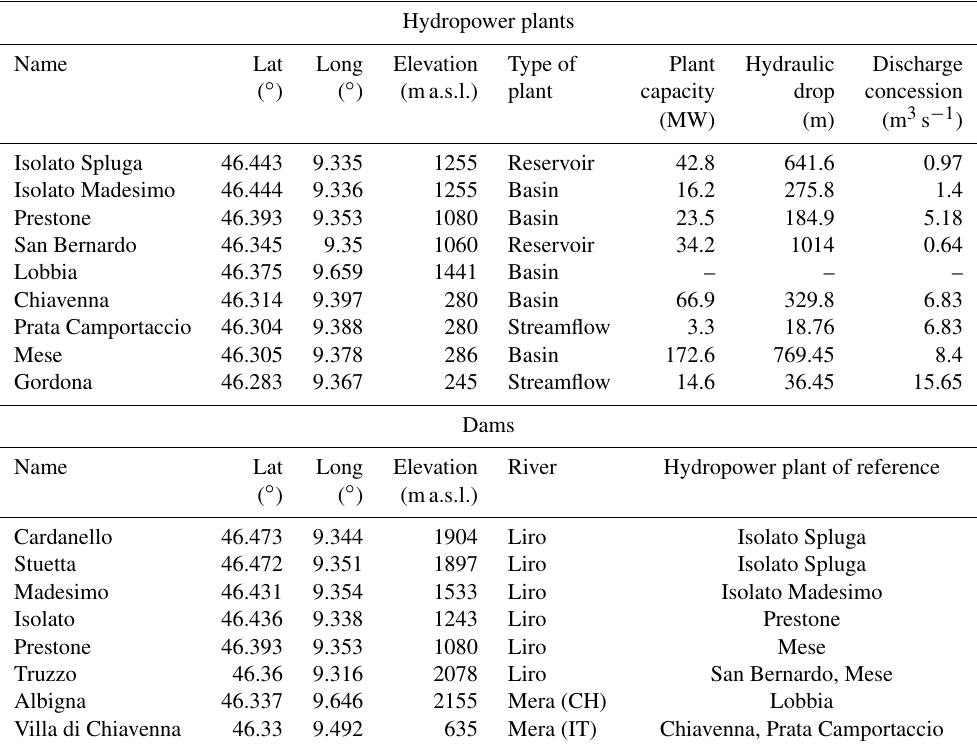
Figure 1. The Mera and Dischma catchments. Table 1. Description of hydropower plants and dams exploiting Mera water resources. The Liro stream is one of the main tributaries of the Mera River and joins the latter in Prata